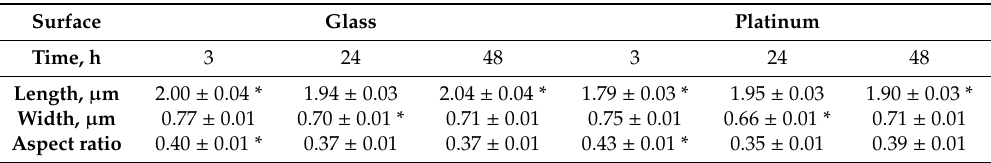
Table 1. Average dimensions of bacterial cells. Comparison of average values of length, width and aspect ratio of bacteria cultured on bare and Pt-coated glass slides for 3 h, 24 h and 48 h; * = p < 0.05, n =